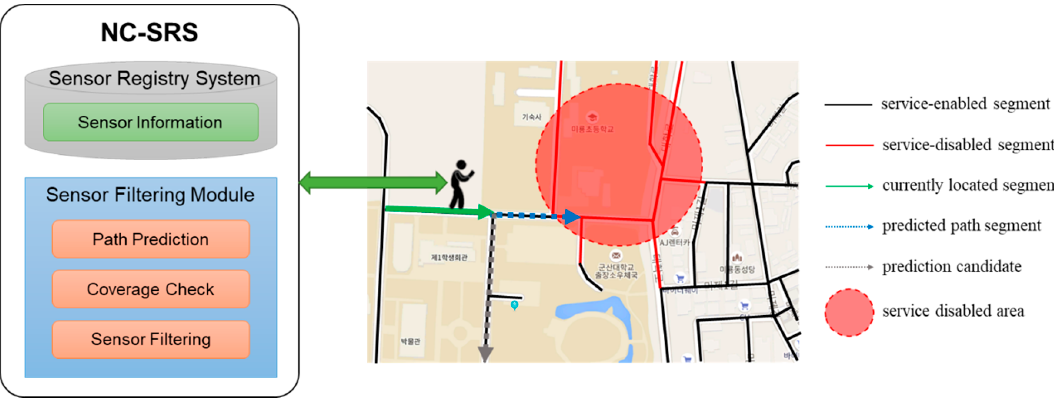
Figure 2. Concept of the network coverage information-based sensor registry system (NC-SRS) using a segment.